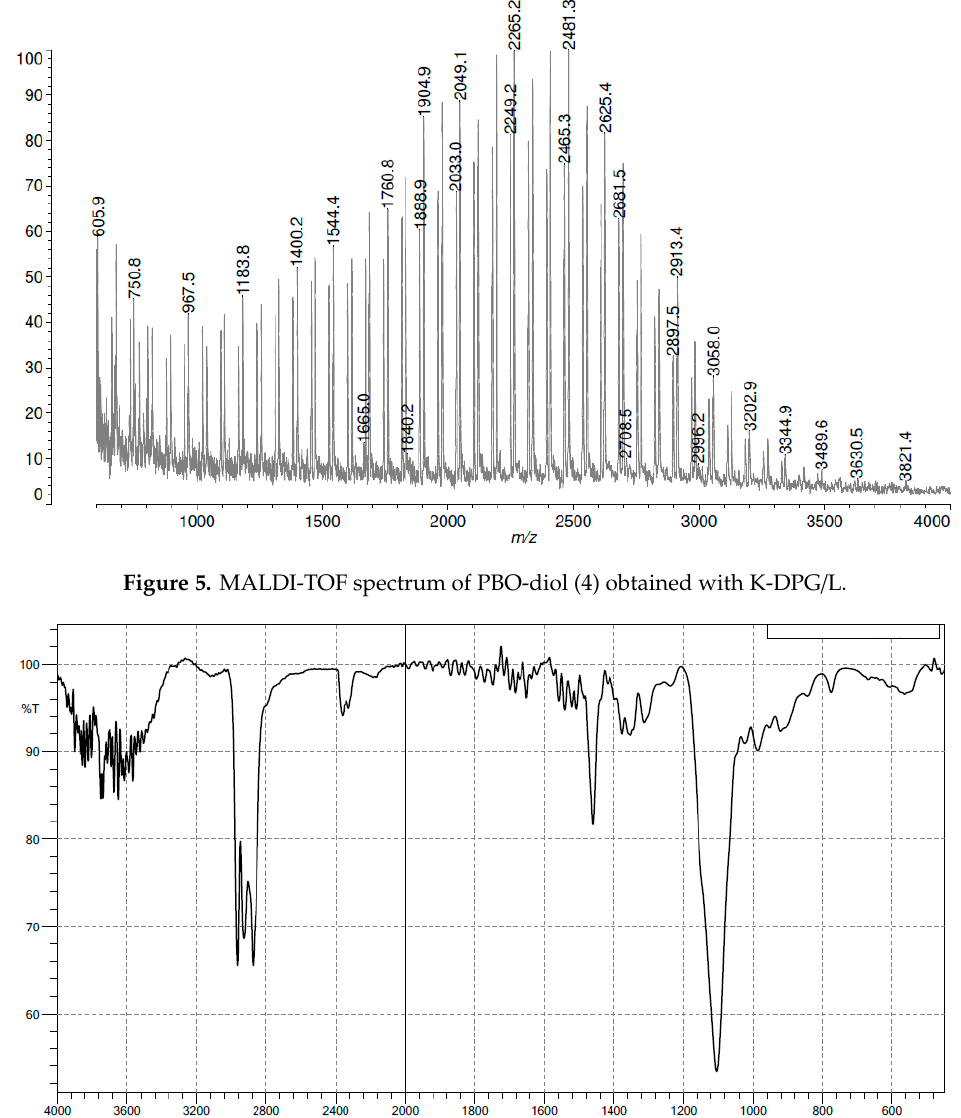
Figure 6. FTIR spectrum of PBO-diol (4).